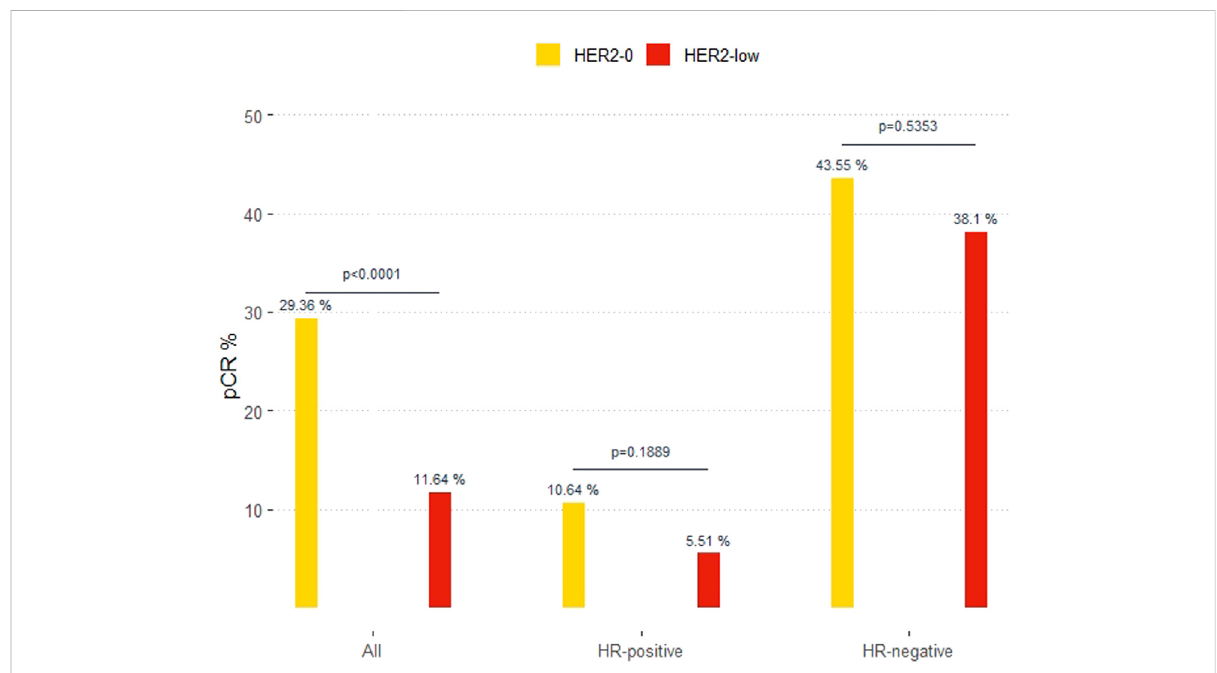
FIGURE 2 Pathological complete response (pCR) in HER2-0 and HER2-low overall and by hormone-receptor (HR)